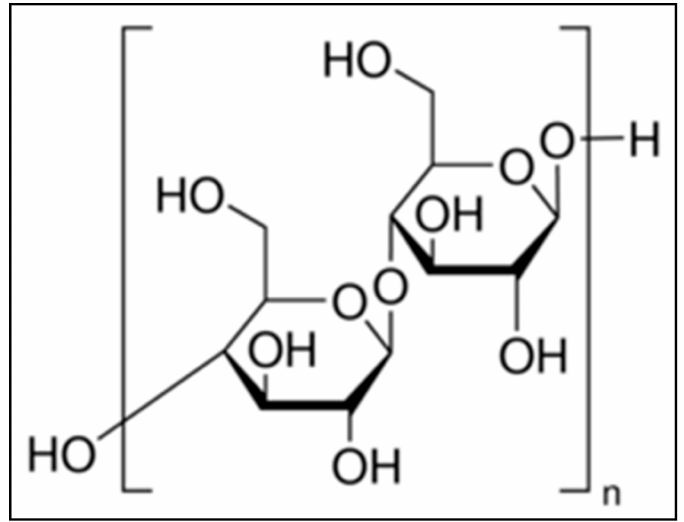
Figure 1. Chemical structure of α